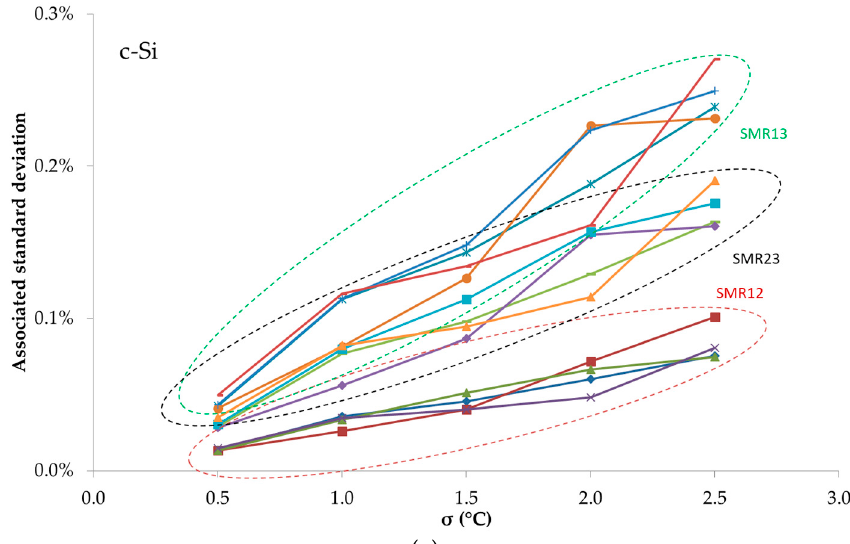
Figure 8. Weighting factor generated in 3 different Monte Carlo runs to adjust the spectrum in the InGaAs and c-Si regions independently. The weighting factor is always equal to one except in the interested wavelengths, where the spectrum is scaled up or down depending on the random number sampled from the Gaussian distribution.